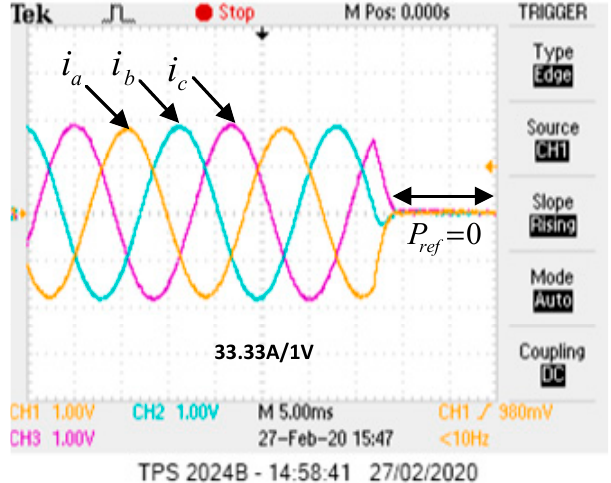
Figure 10. Voltage and current for phase C during Pref = 0 to Pref = 10 kW.